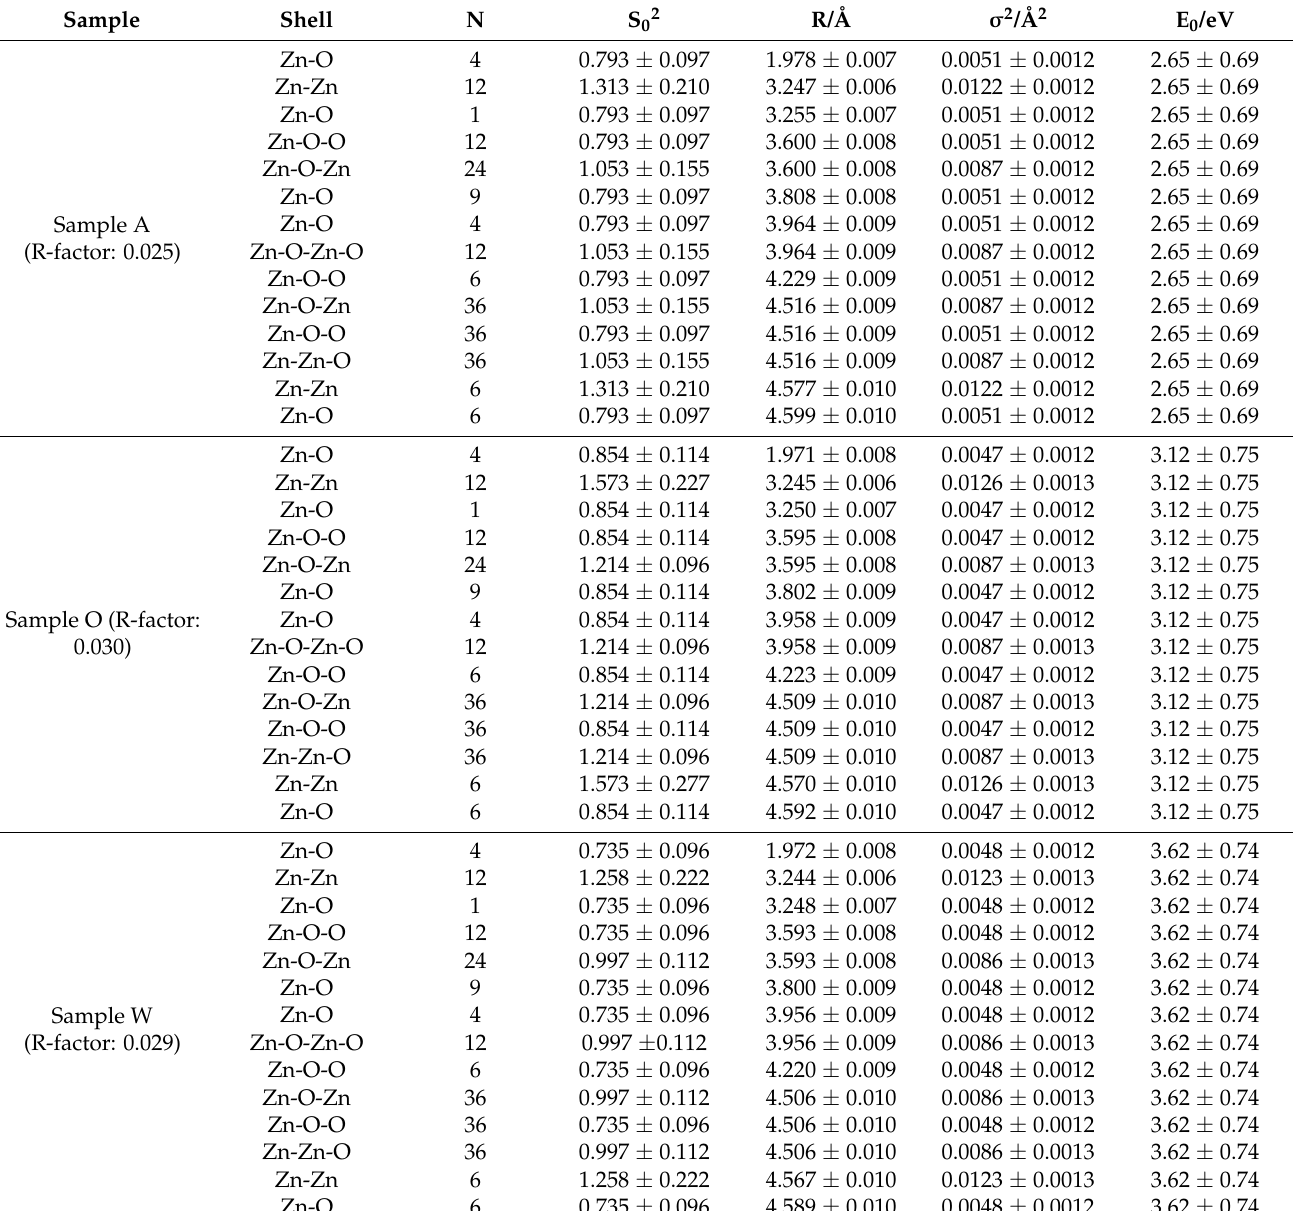
Table 2. Compilation of quantitative fit results obtained from a detailed EXAFS data analysis for samples A, O and W after extraction of the synthesized ZnO nanomaterials from the reaction